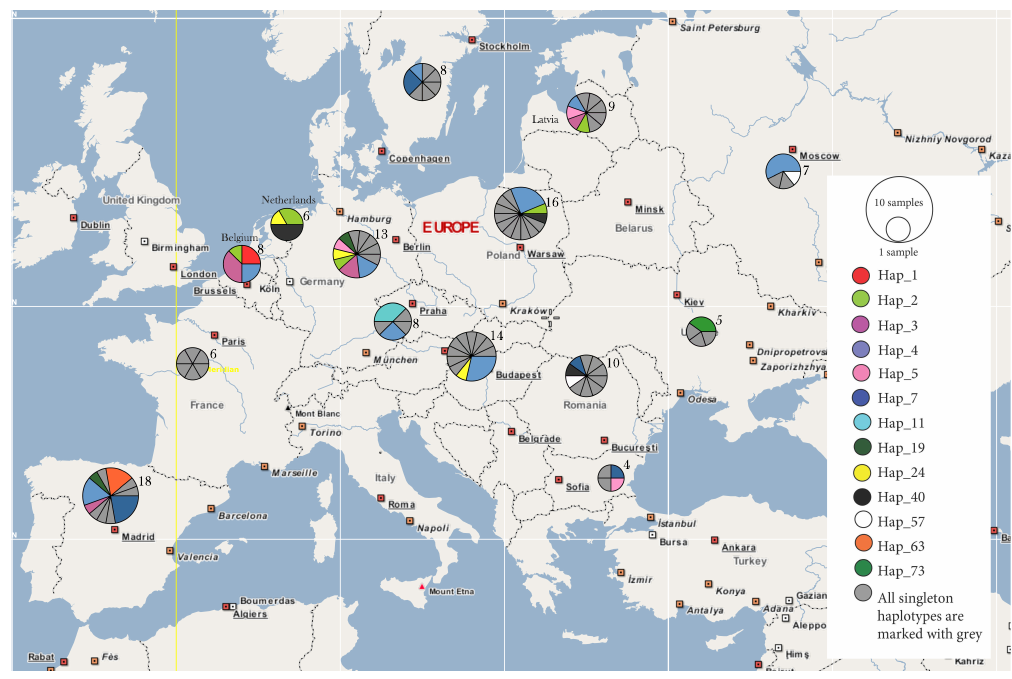
Figure 3. Geographic distribution of the 76 haplotypes based on concatenated Cytb and CO1 , as represented by our mtDNA data from 132 birds in 14 countries. On the right-side legend panel, each shared haplotype is assigned with a different color, whereas all singleton haplotypes are marked with grey. On the map, the unit near each circle indicates number of samples for the respective